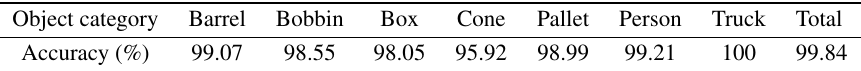
Table 2. Results of object recognition on the synthetic dataset using the trained deep classifier Barrel Bobbin Box Cone Pallet